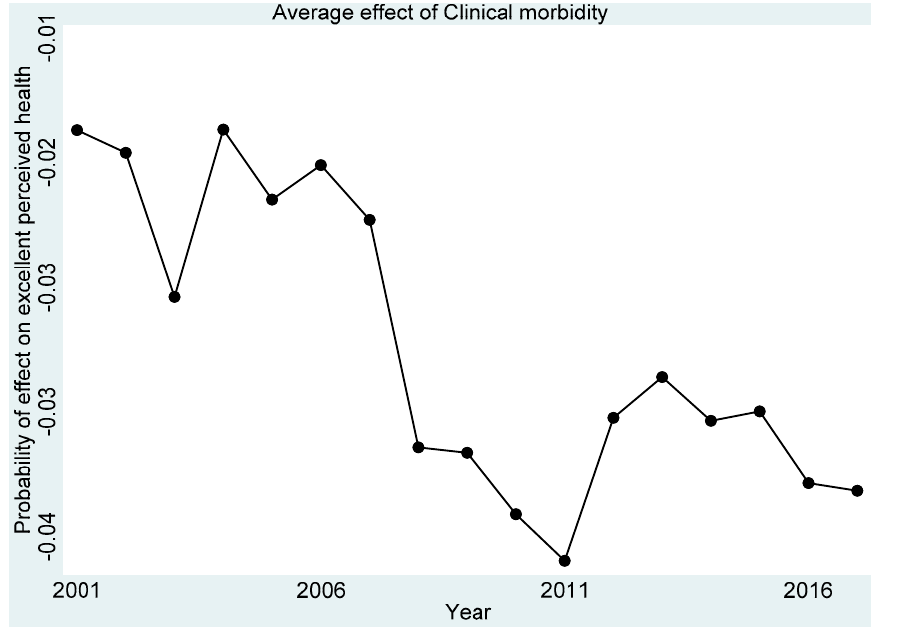
Figure 5. Probability of effects on “excellent” perceived health from the average effect of clinical morbidity.